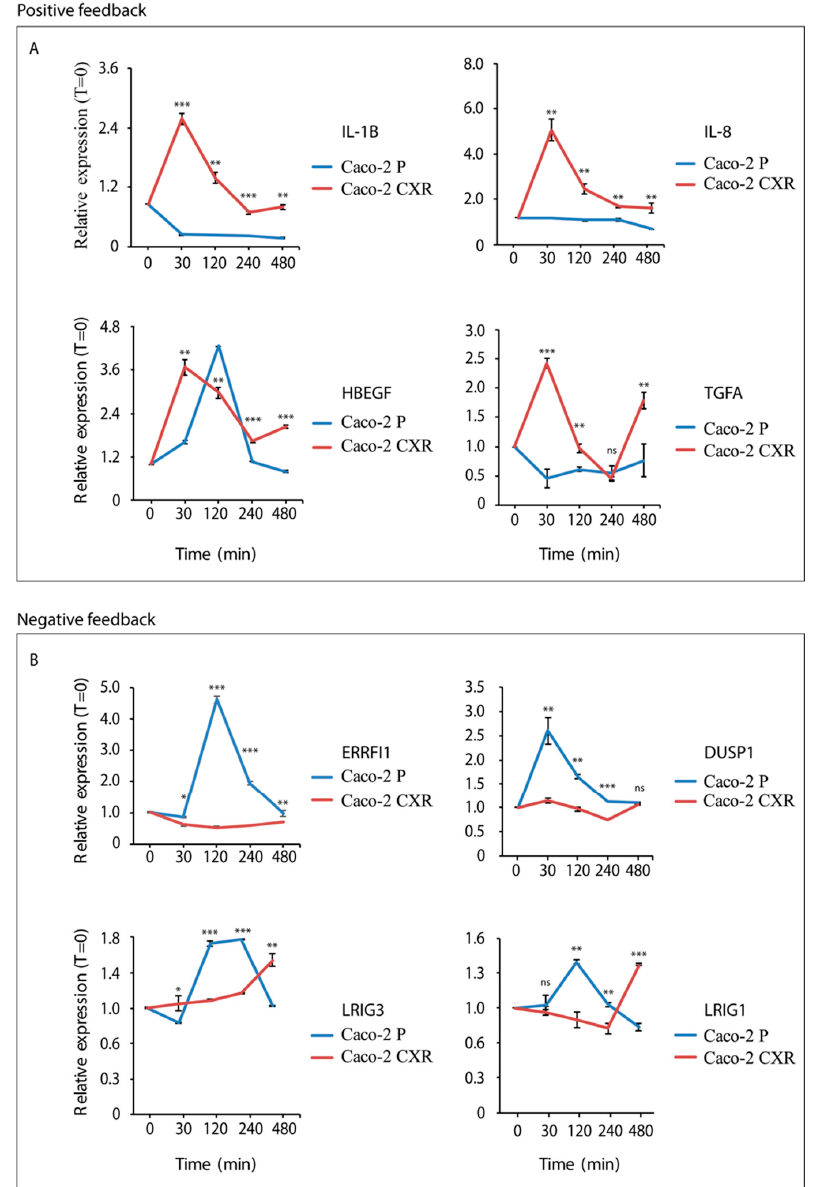
Figure 2. EGFR positive and negative feedback loops in Caco-2 Parental and Caco-2 cetuximab resistant (CXR) cell lines. Caco-2 Parental and Caco-2 CXR cell lines were treated in combination with cetuximab (CTX) (2 µg/mL) and EGF (20 ng/mL) at different time points (30, 120, 240 and 480 min) and qPCR analysis of EGFR positive (IL-1B, IL-8, HBEGF and TGFA) and negative (ERRFI1, DUSP1, LRIG1 and LRIG3) feedback genes was performed. In ( A ) EGFR positive feedback gene expression is reported. Caco-2 CXR activated immediate transcription of IL-1B, IL-8 and TGFA after 30 min from treatment and a decline of transcription level occurred after 4 hours, whereas Caco-2 Parental cells displayed non-significant changes in expression of IL-1B, IL-8 and TGFA. HBEGF displayed an overlapping profile in both Caco-2 Parental and CXR cell lines. In ( B ) EGFR negative feedback gene expression is reported. Caco-2 Parental cells showed an increase in the expression of ERRFI1, DUSP1, LRIG3 and LRIG1 genes, which was not observed in CXR cells. Statistical test of triplicated data was determined by multiple t-test, using the Holm-Sidak method, with alpha = 5%. Each row was analyzed individually, without assuming a consistent (standard deviation) SD. *** p < 0.0005, ** p < 0.01, * p < 0.05 and ns (not significant).